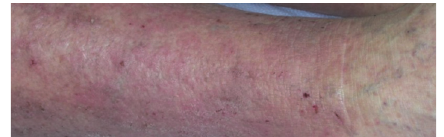
Figure 1: Changes of stasis dermatitis with skin